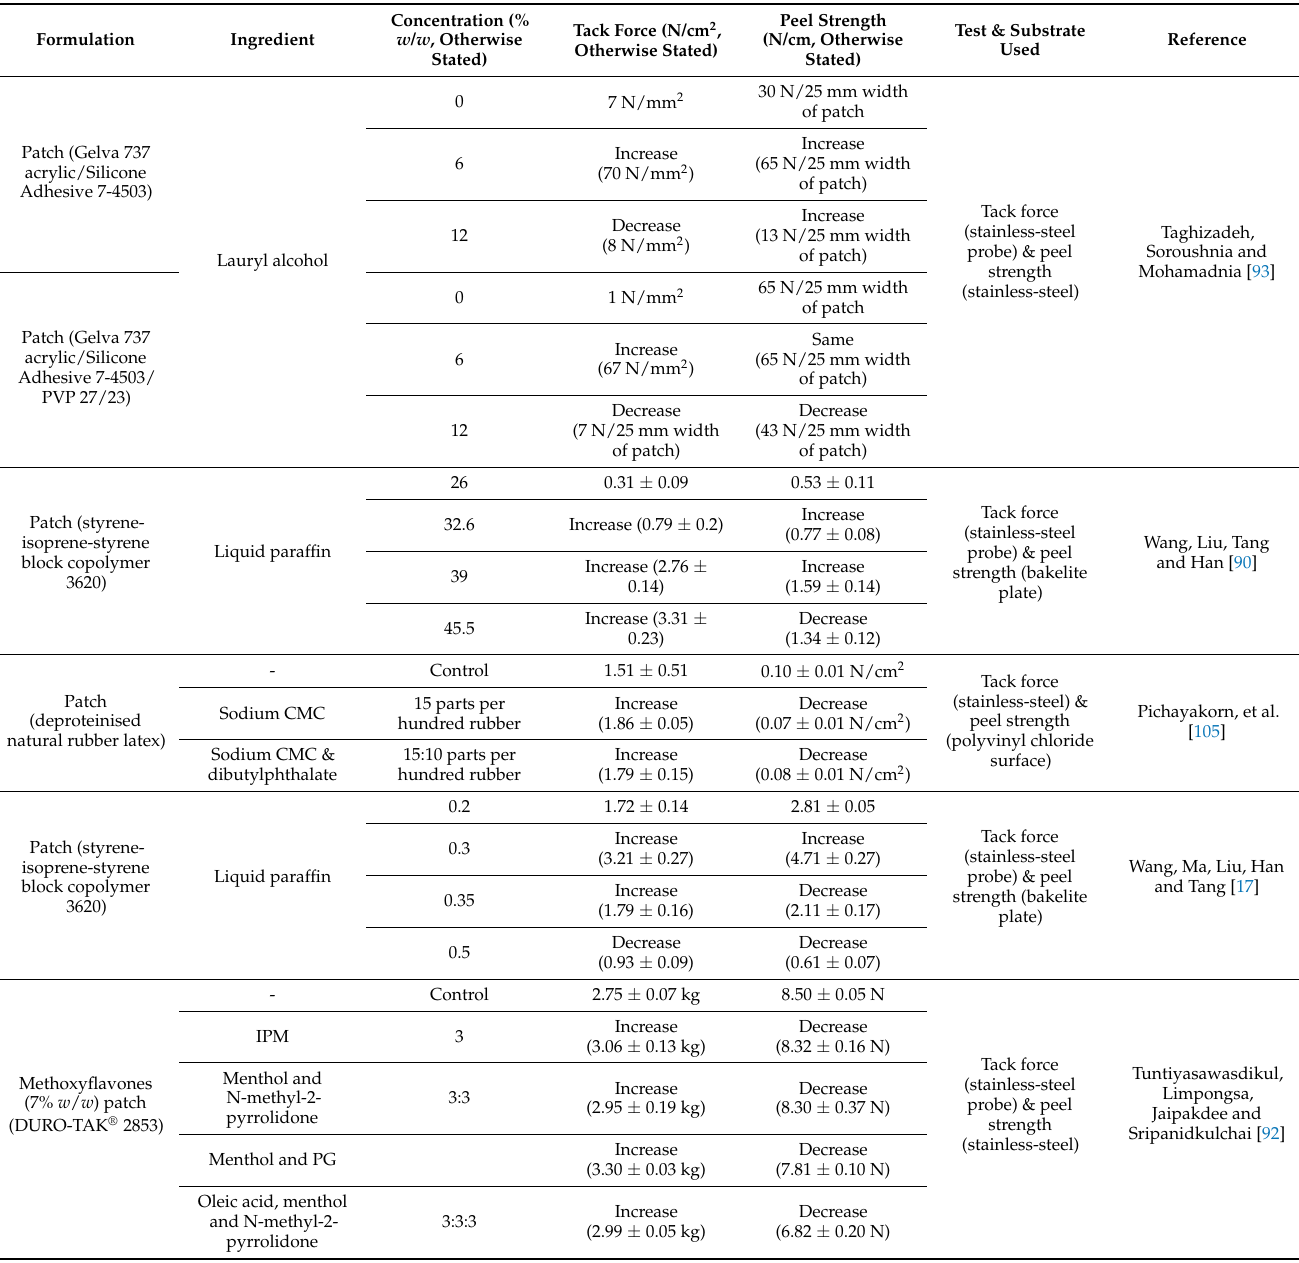
Figure 5 represents in vitro drug release studies using MS-loaded patches over 24 h. The release of MS from MS-P reaches the maximum at 12 h (22.5 ± 0.9%) before a decrease in drug release to 20.3 ± 0.9% at 24 h, probably due to the loss of volatile MS. With the aid of solvents, MS was released more slowly, except for TRC-P. TRC-P showed a steady increase in drug release over 24 h with a total of 26.8 ± 1.4% of MS released, which is higher than that achieved by MS-P. The rest of the patches generally showed a lower drug release from 4 h onwards with a final MS release ranging from ~16 to 21% at 24